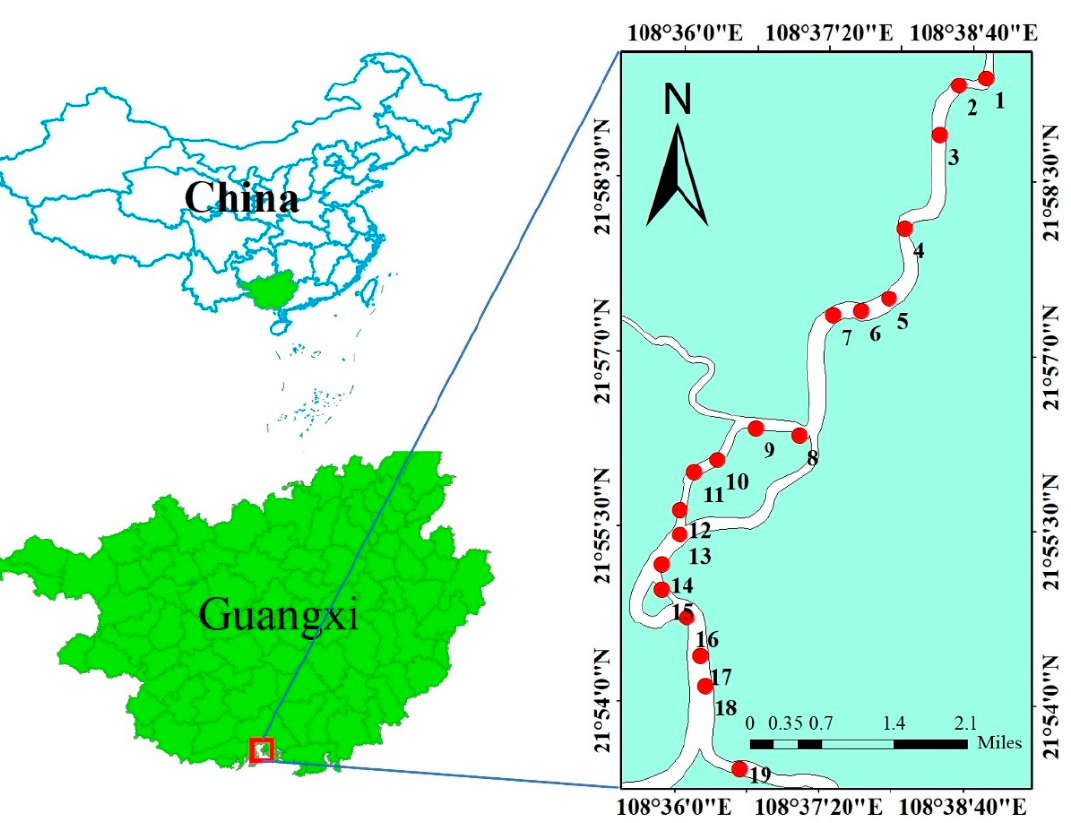
Figure 1. Location of the study area and sample sites.